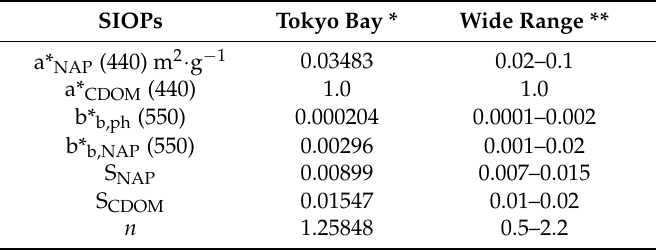
Table 2. Values of Specific inherent optical properties (SIOPs) used in the bio-optical model to generate simulated